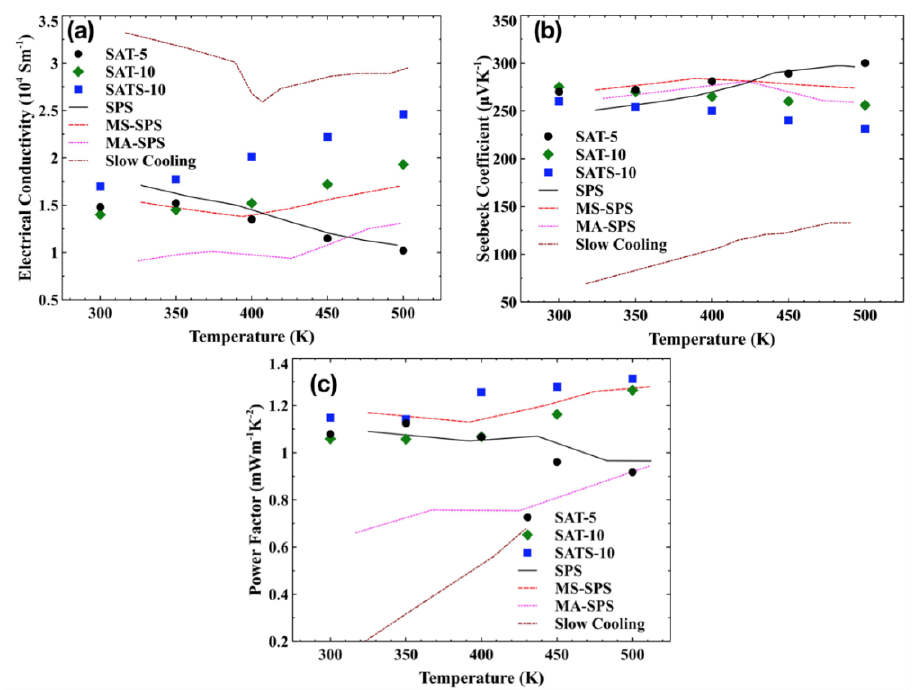
Figure 4. Temperature dependence of ( a ) the electrical conductivity, ( b ) the Seebeck coefficient, ( c ) the power factor of SAT-5 (black circle), SAT-10 (green diamond) and SATS-10 (blue square) thick films developed by melt spinning. For comparison, reference samples prepared by spark-plasma-sintering (SPS, black solid line) [26], melt-spinning-spark-plasma-sintering (MS-SPS, red dash line) [4], mechanical-alloying-spark-plasma-sintering (MA-SPS, magenta dotted line) [10] and melt-slow-cooling (Slow cooling, dark red dash-dot line) [14] were also included. Table 1. Hall coefficients of thick films developed by melt spinning. Films